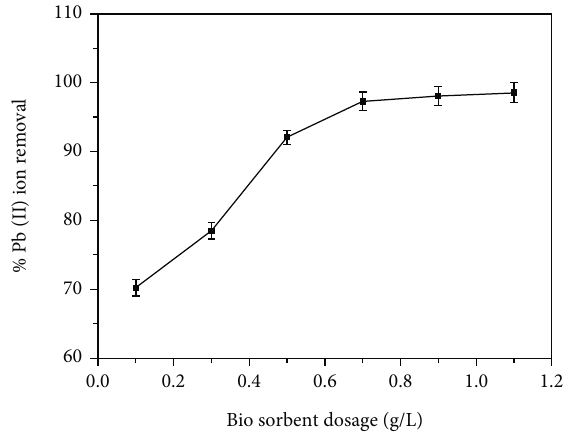
Figure 10: E ff ect of bioadsorbent dosage on adsorption behavior of Pb 2+ ion at constant Pb 2+ ion concentration of 100mg/L, stirring speed of 300 rpm, temperature of 25 ° C, pH of 6, and contacting time of 60min.